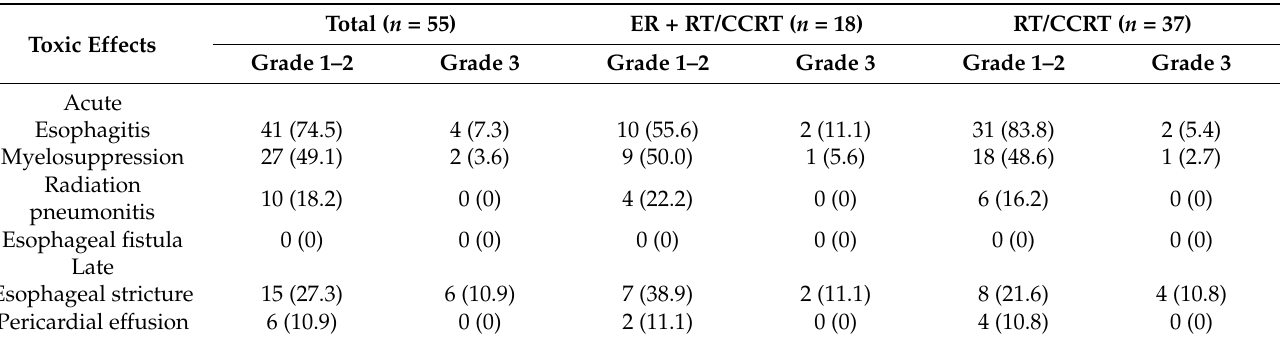
Table 4. Toxicities [ n (%)] †,‡